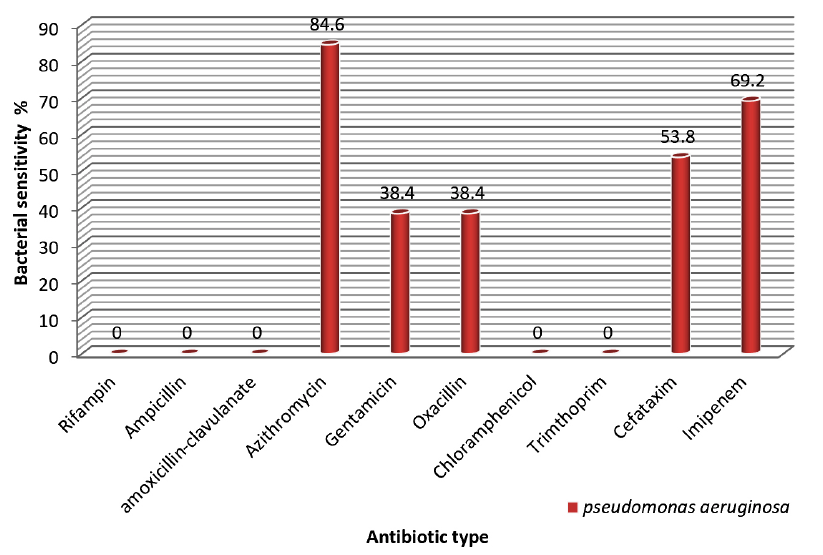
Fig. 3. Sensitivity pattern of Pseudomonas aeruginosa toward different antibiotics